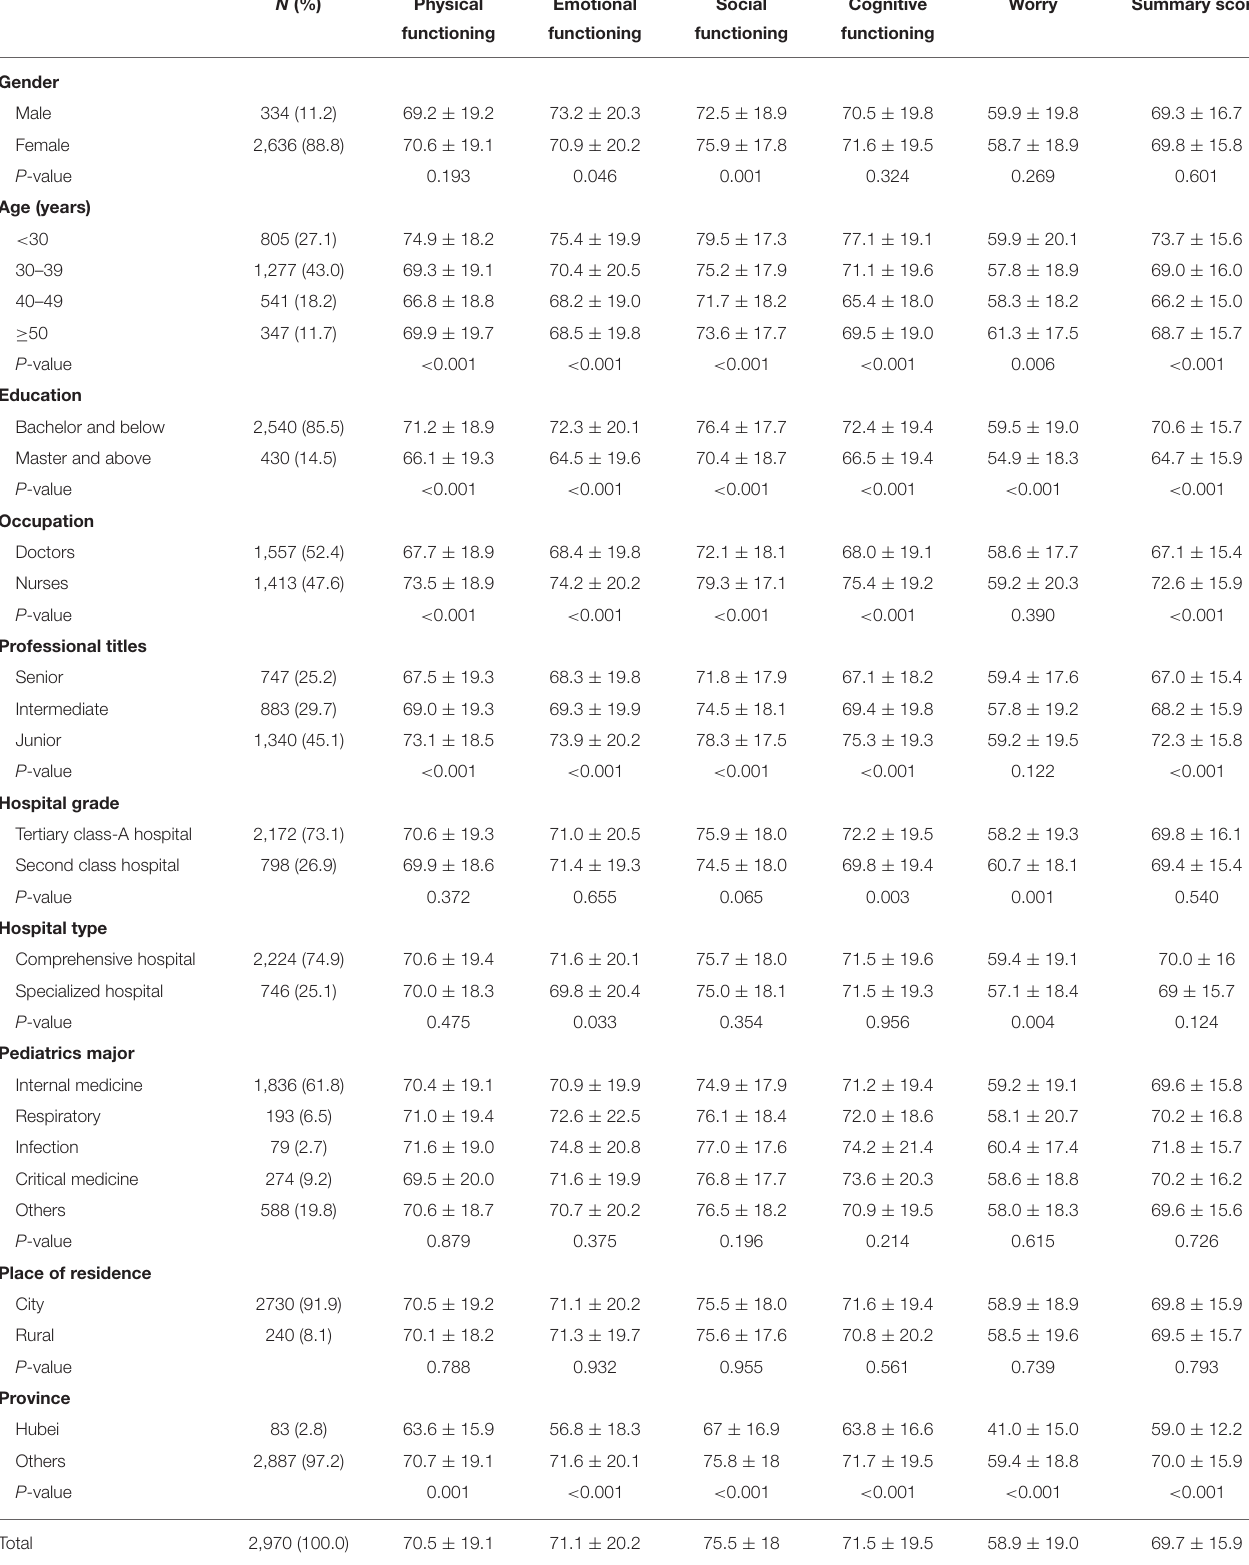
TABLE 1 | HRQoL based on socio-demographic characteristics (mean ± sd ). N (%) Physical Emotional Social Cognitive Worry Summary score functioning